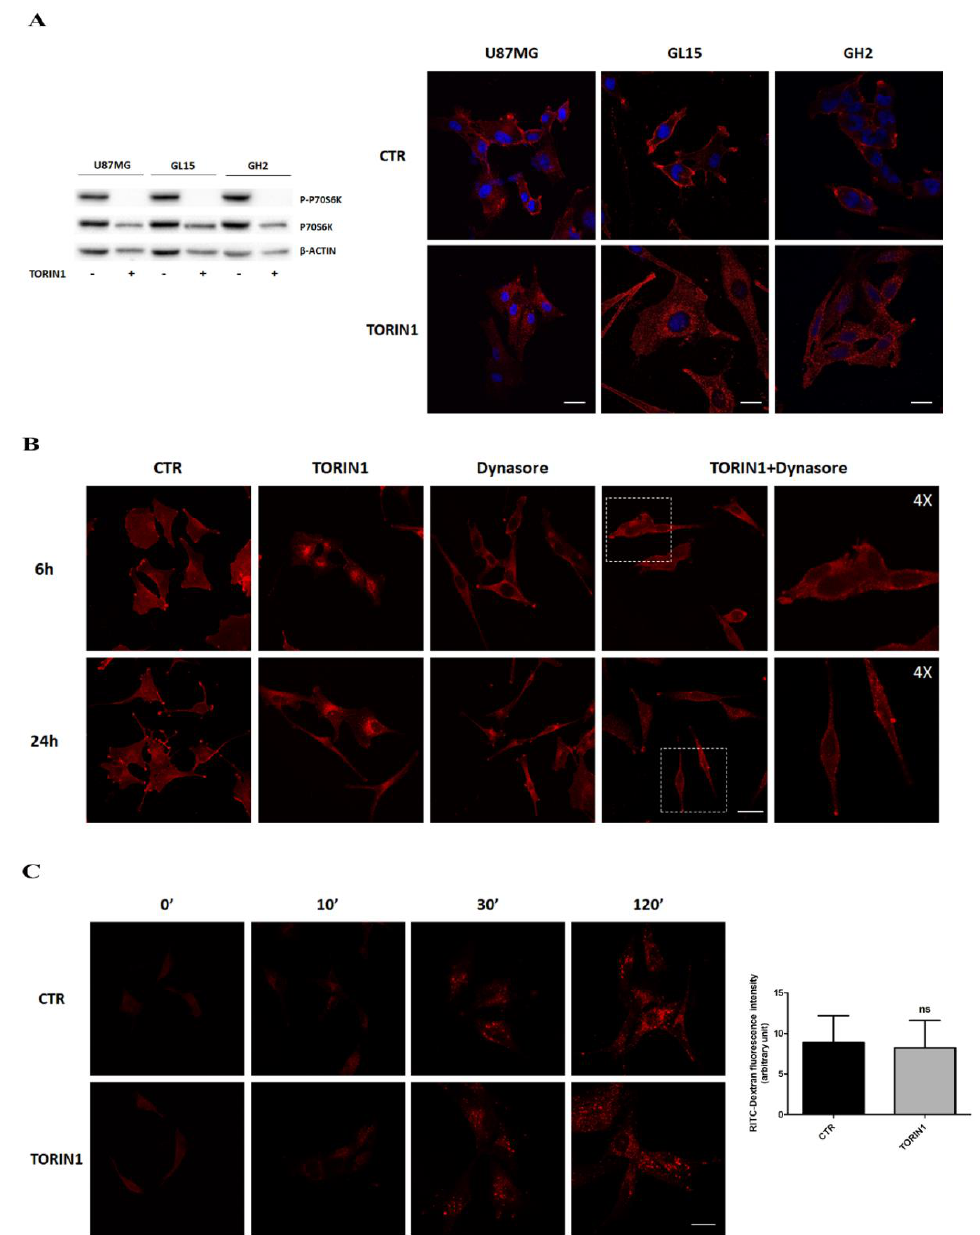
Figure 1. Epidermal Growth Factor receptor (EGFR) internalises into Glioblastoma multiforme (GBM) cells upon mTOR inhibition. ( A ) U87MG (upper panels), GL15 (middle panels) and primary GH2 cells (lower panels) were cultured in complete medium (DMEM) (CTR) or in DMEM in the presence of 250 nM Torin1 for 18 h. Immunocytochemistry and confocal analysis for EGFR localisation (red) were then performed. Hoechst 33342 was used to stain nuclei (blue). Scale bar, 30 µ M. Western blot analysis of P-p70S6K and p70S6K was performed to check mTOR pathway inhibition by Torin1. β -actin was used as loading control. The blots are representative of three independent experiments. ( B ) Immunocytochemistry and confocal analysis for EGFR localisation (red) were performed in U87MG cells, upon 6 h and 24 h Torin1 treatment in the presence or absence of 100 µ M Dynasore. Scale bar, 30 μM. A 4× magnification is shown for the right panels representing cells treated with Torin1 plus Dynasore. ( C ) U87MG cells were incubated with 0.5 mg/mL Rhodamine Dextran for the indicated times and its uptake within the cells analysed by image capturing at the confocal microscope. Scale bar, 30 μM. Fluorescence quantification of Dextran uptake at 120′ is shown in the right panel.